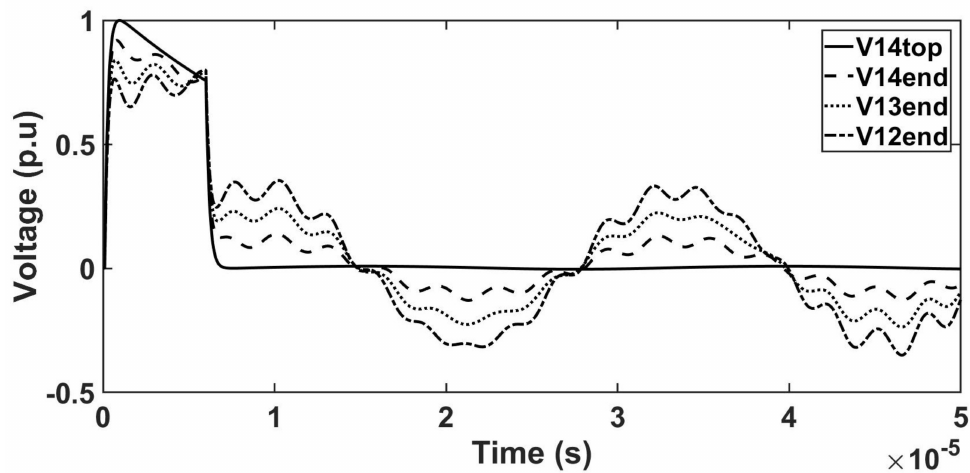
Figure 21. Surge voltage waveforms for shield placement between layer 14 and 13 under CLI.